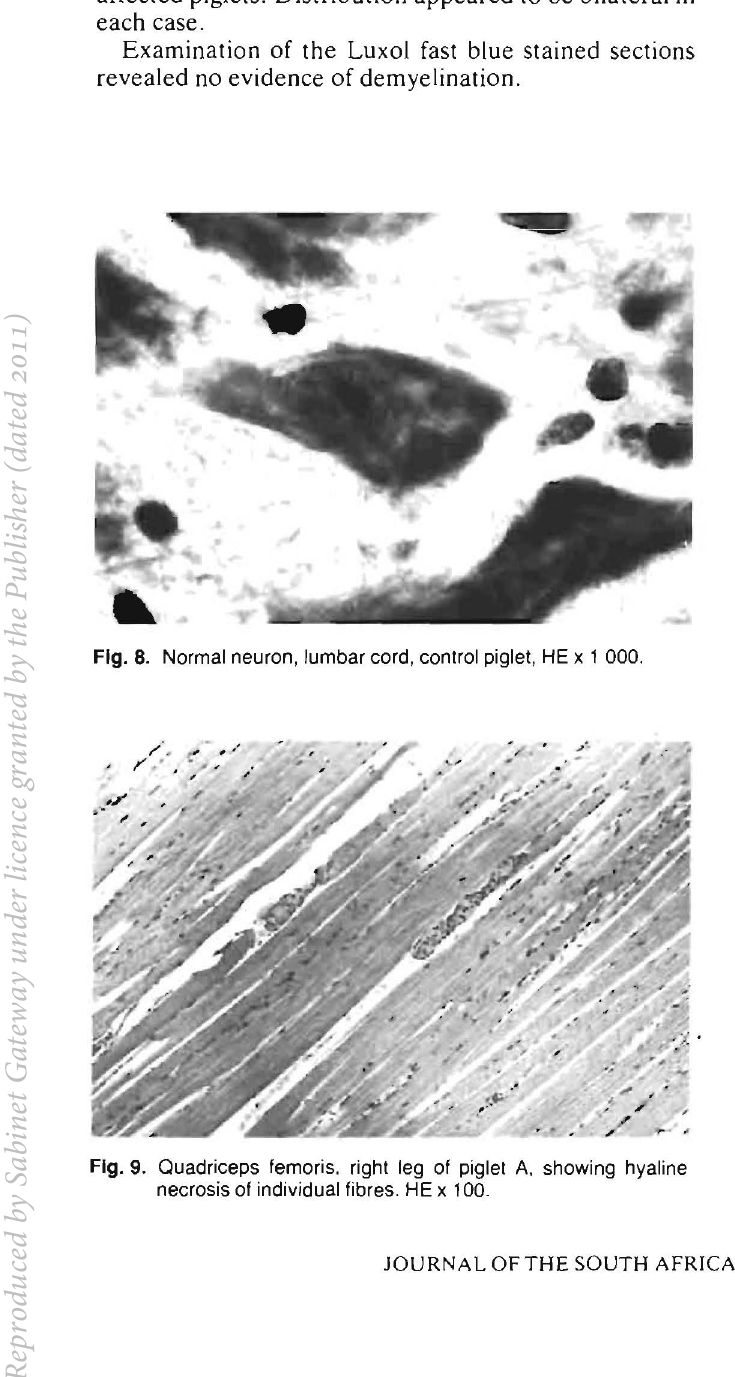
Fig. 9. Quadriceps femoris. right leg of piglet A. showing hyaline necrosis of individual fibres. HE x